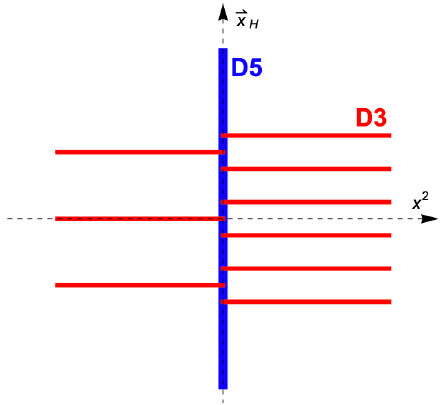
Figure 1 . Cartoon of the intersecting brane system. The D5-brane stack sits at x 2 = 0 . The asymptotic position of the D3-branes in the directions labeled ~x the diagonal components of the triplet X H